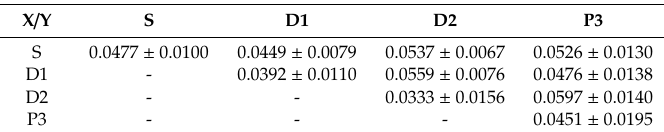
Table 6. Synonymous nucleotide diversity ( π s ) in the coding region between locus X, rows, and Y, columns, and the standard deviation in π s